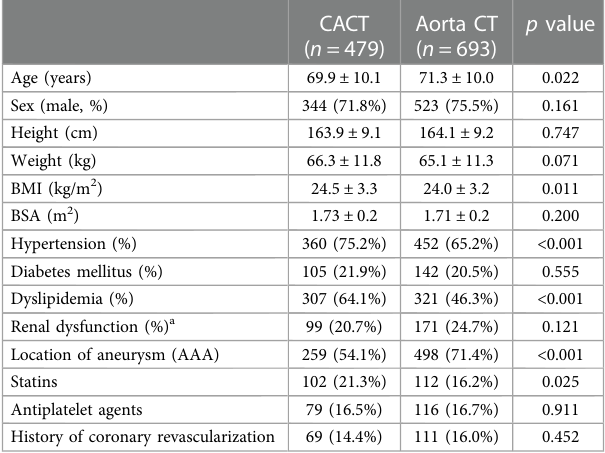
TABLE 1 Baseline characteristics of the patients who underwent CACT or aorta